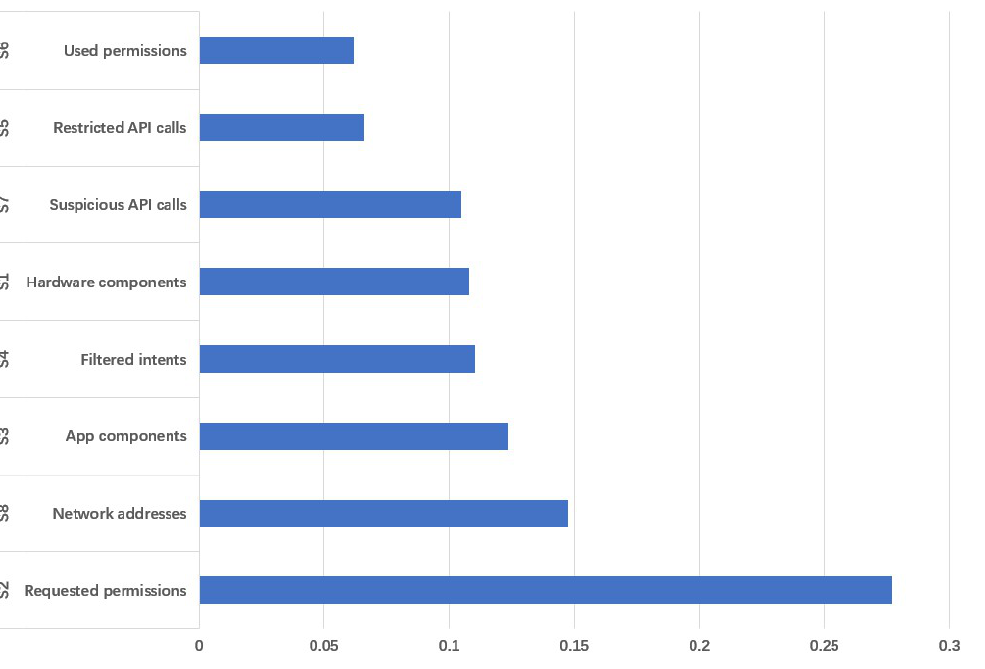
Figure 2. The sorting result of feature importance. The ordinate represents different behavioral feature categories and the abscissa represents the proportion of